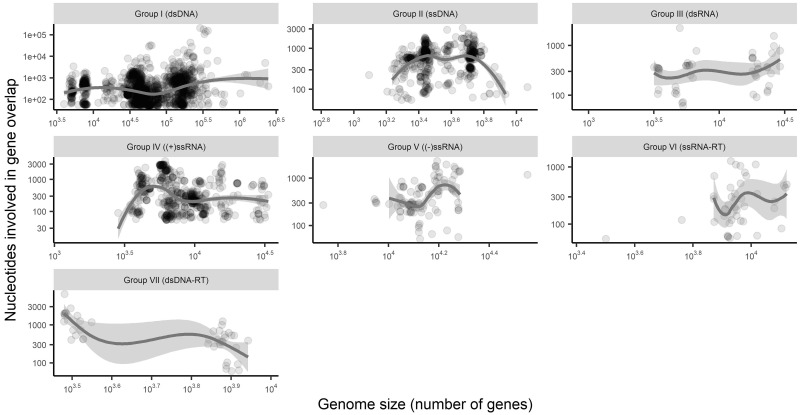
Total number of nucleotides involved in gene overlap by genome size (excluding all genomes with no overlap). Trend lines are Loess curves with span 0.80. Both the x and y axes depict log scales.